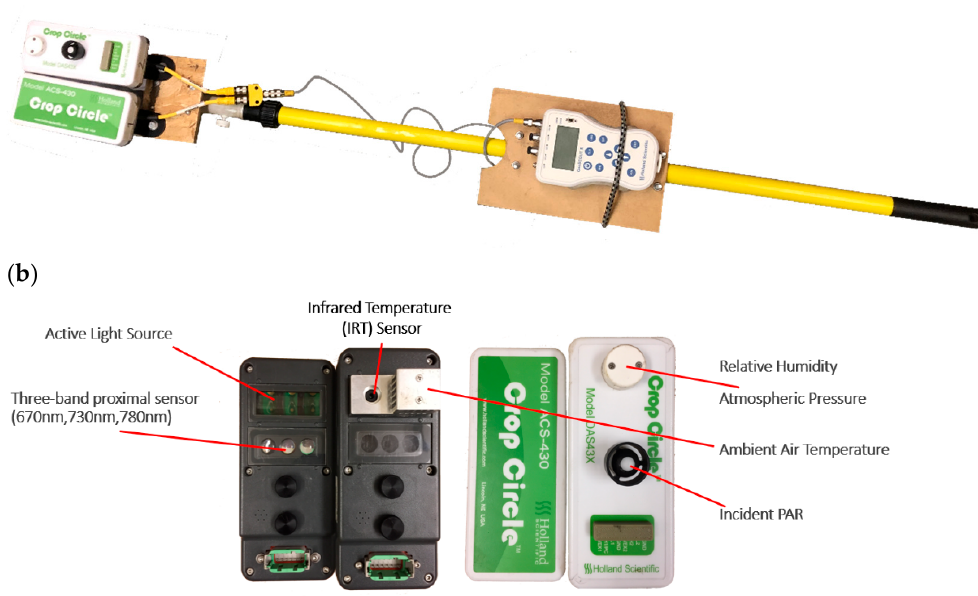
Figure 2. Crop Circle Phenom sensor ( a ) custom assembly with extendable pole and ( b ) close up view of ACS-430 and DAS43X sensor components.